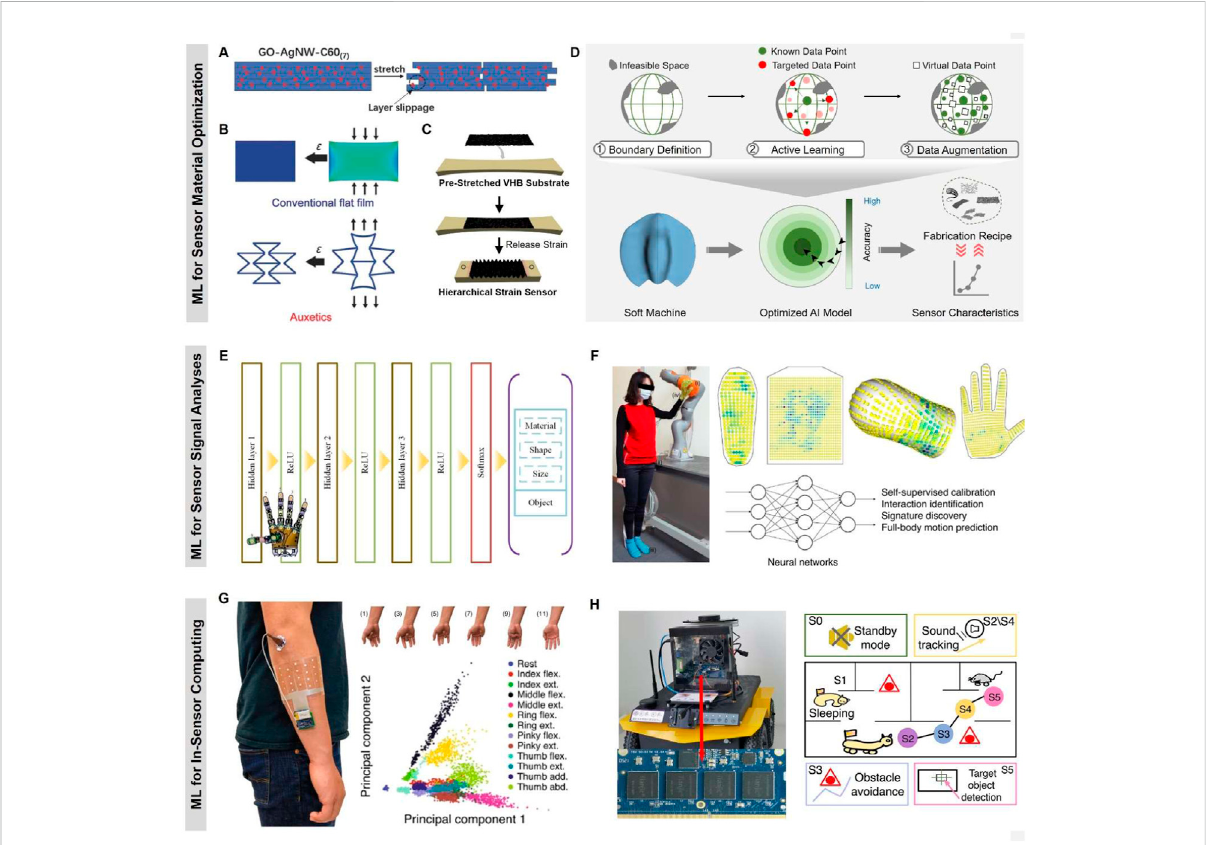
FIGURE 1 ML for Strain Sensor-Integrated Soft Robots. (A) Schematic illustration of sensing mechanism for GO – AgNW – C60 sensing fi lms under stretching, where the layers partially slide out inside the crack in the sensing fi lm. Reproduced with permission from Shi et al. (2018a). Copyright: WILEY-VCH Verlag GmbH & Co. (B) Comparison of the sensor structures between conventional fl at fi lm structure and auxetic metamaterial structure, with corresponding deformation under 15% tensile strain. Reproduced with permission from Jiang et al. (2018). Copyright: WILEY- VCH Verlag GmbH & Co. (C) MXene strain sensor with hierarchical surface topography. Reproduced with permission from Yang et al. (2020). Copyright:AmericanChemical Society. (D) Three-stageframeworkfor constructionofanML-enabledpredictionmodelcapableofautomaticstrain sensor design for soft robots. Reproduced with permission from Yang et al. (2022). Copyright: Springer Nature. (E) A robot hand is integrated with tactile sensors and the multilayer perceptron model. With the aid of ML tools, the robot hand could identify object material, shape, and size. Reproduced with permission from Li et al. (2020). Copyright: American Association for the Advancement of Science. (F) Digitally designed full-sized tactile sensing wearables, which collected the tactile frames during human – environment interactions and explored their applications using ML techniques. Reproduced with permission from Luo et al. (2021). Copyright: Springer Nature. (G) Wearable biosensing system with adaptive machine learning for real-time prediction of hand gestures. Reproducedwith permission from Moin et al. (2021). Copyright:Springer Nature. (H) The physical pictureoftheTianjicat robot,thedevelopmentboard,and theTianjicXchip array.Byequipping withTianjicXandmultimodalsensors,aroboticcaris able to simultaneously process multisensory information locally for various tasks including object detection, obstacle avoidance, and decision- making. Reproduced with permission from Ma et al. (2022). Copyright: American Association for the Advancement of